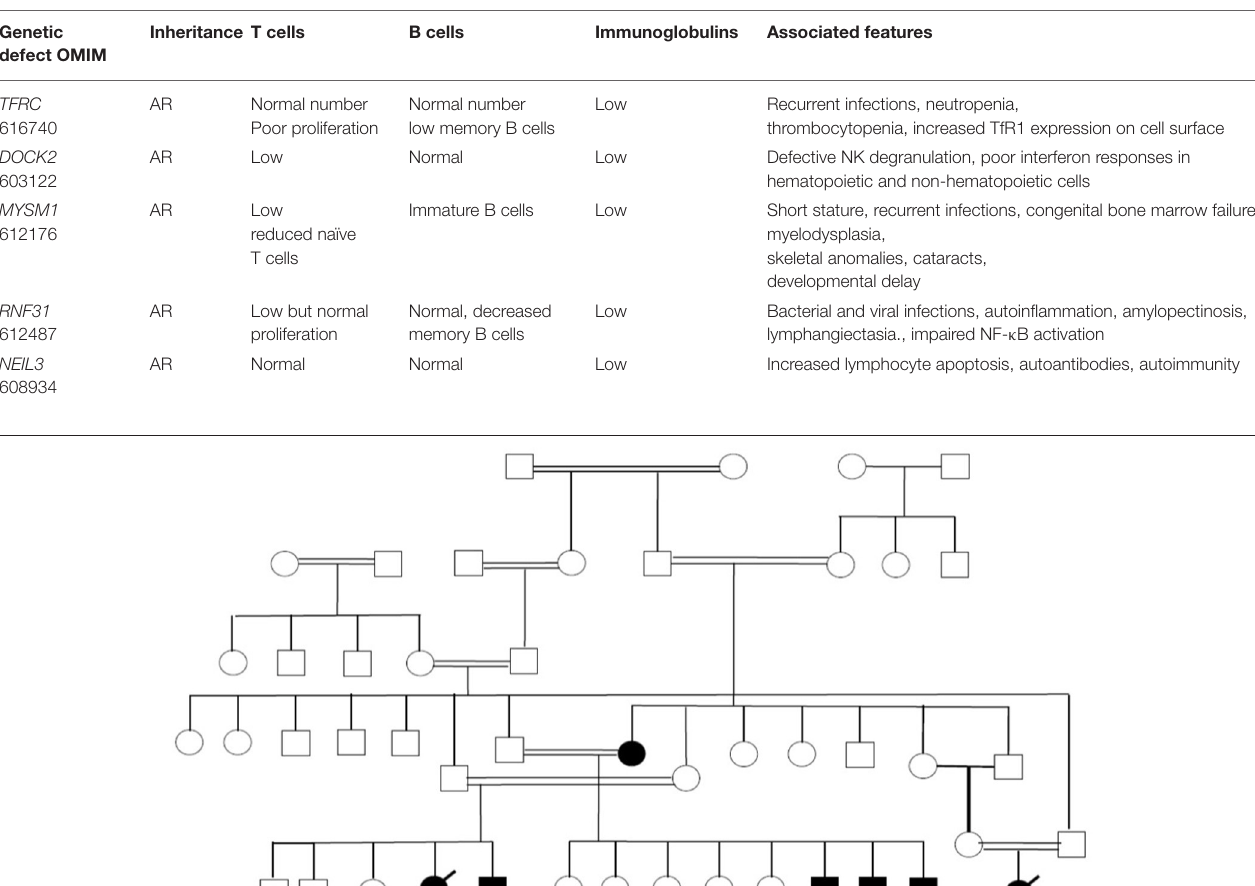
FIGURE 4 | Pedigree showing multiple members of a large family affected with autoimmunity and lymphoproliferation under work-up to identify the underlying genetic